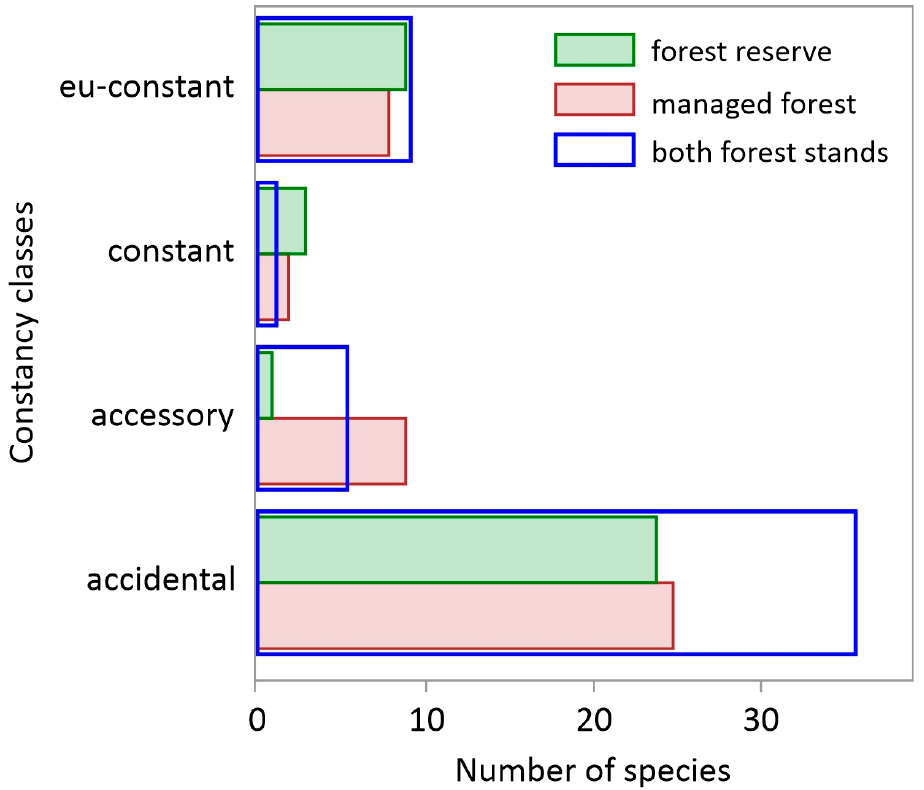
Figure 6. Distribution of the number of beetle species caught in pitfall traps by constancy classes.